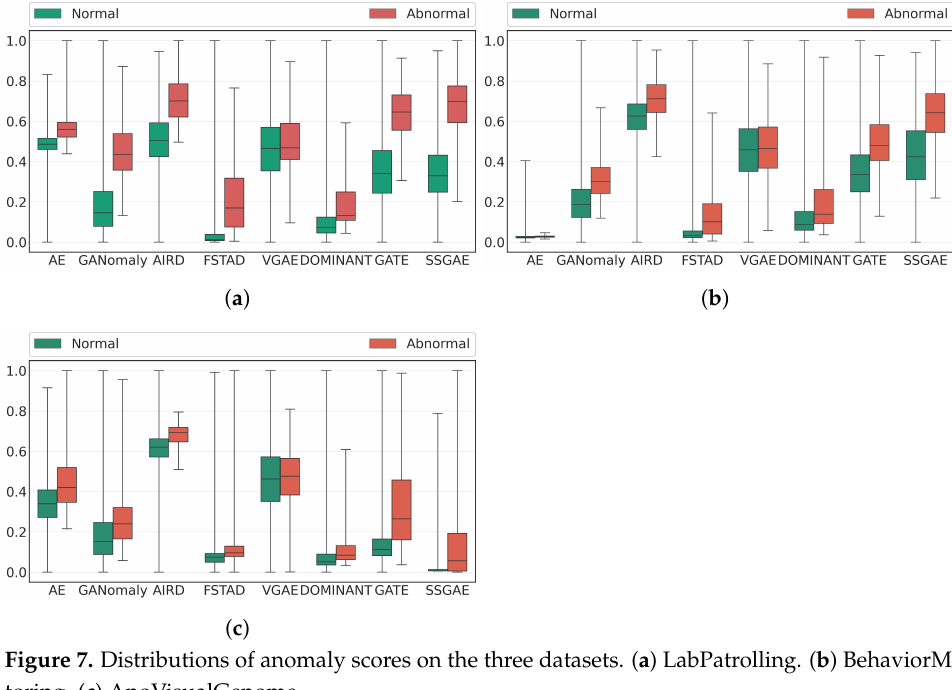
Figure 7. Distributions of anomaly scores on the three datasets. ( a ) LabPatrolling. ( b ) BehaviorMoni- toring. ( c ) AnoVisualGenome.